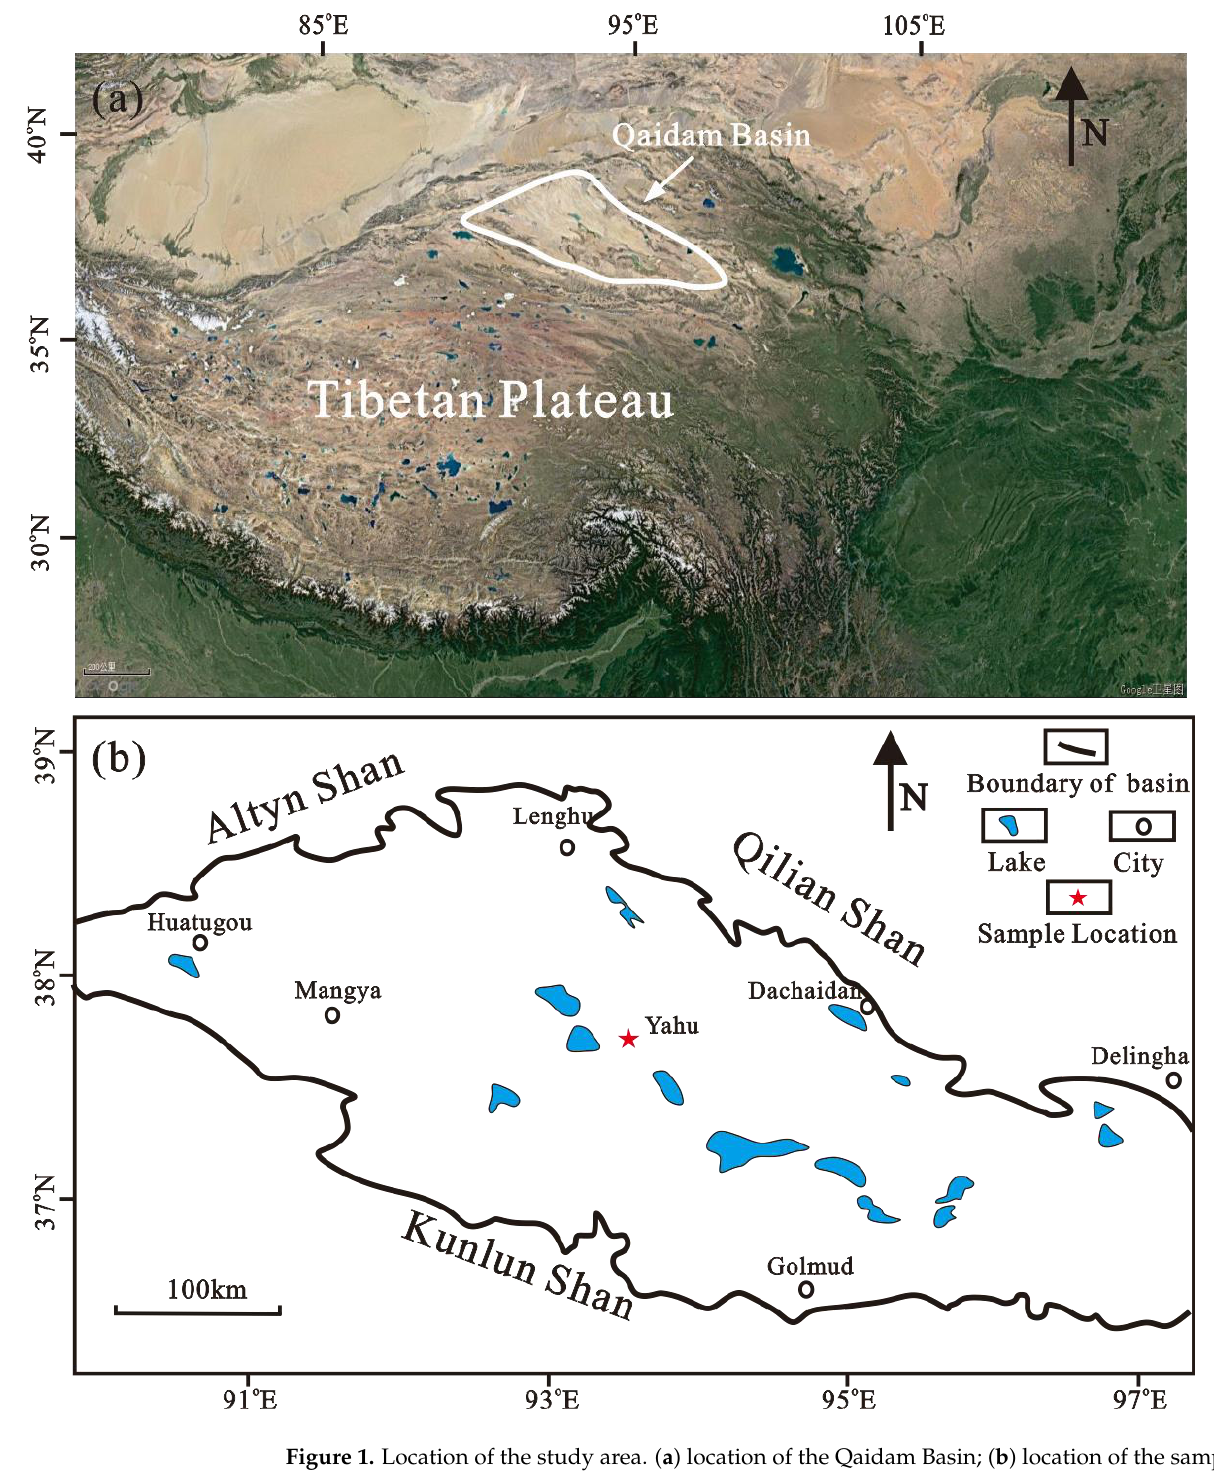
Figure 1. Location of the study area. ( a ) location of the Qaidam Basin; ( b ) location of the sample in the Qaidam Basin. Satellite image taken from Google Earth.